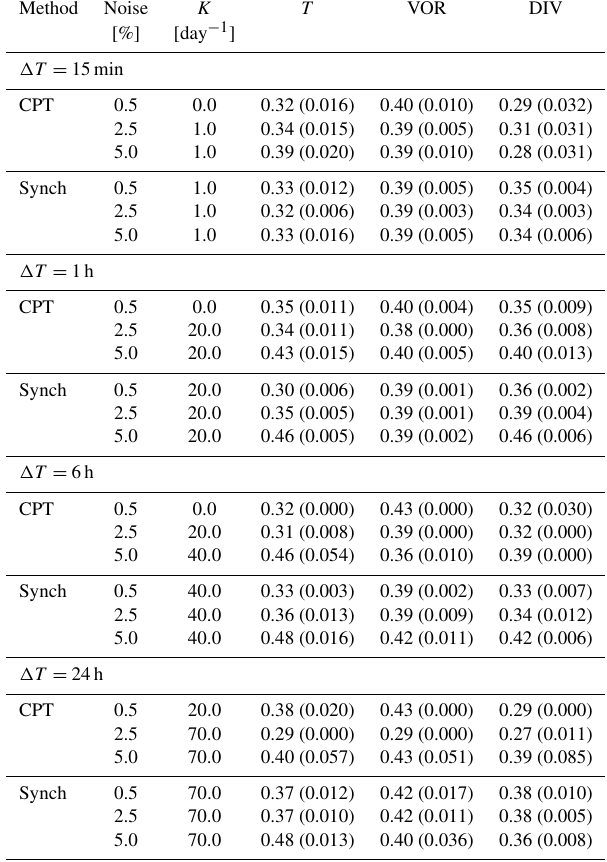
Table 3. Weights for the supermodel trained by the synch rule with an observation available at every second time step and the same amount of nudging towards the observations as in Selten et al. (2017) and Schevenhoven et al. (2019). The weights are averaged over the last 10 weeks of training. The standard deviation is given in parentheses.